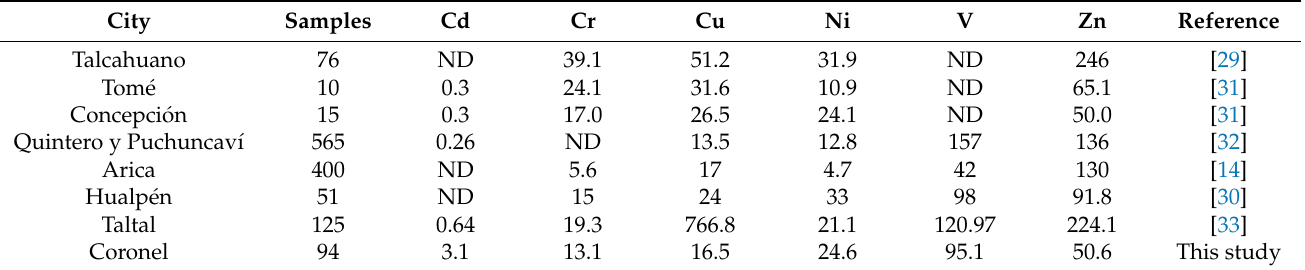
Table 2. Median concentrations (mg × kg − 1 ) reported in publications on urban soils in Chilean